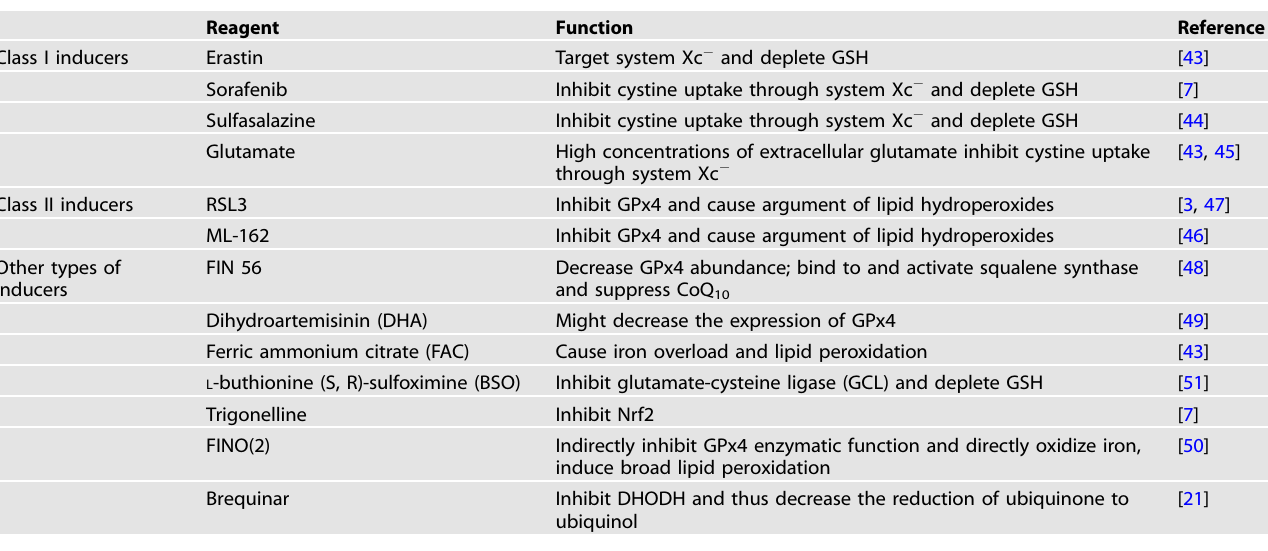
Table 1. Major inducers of ferroptosis.